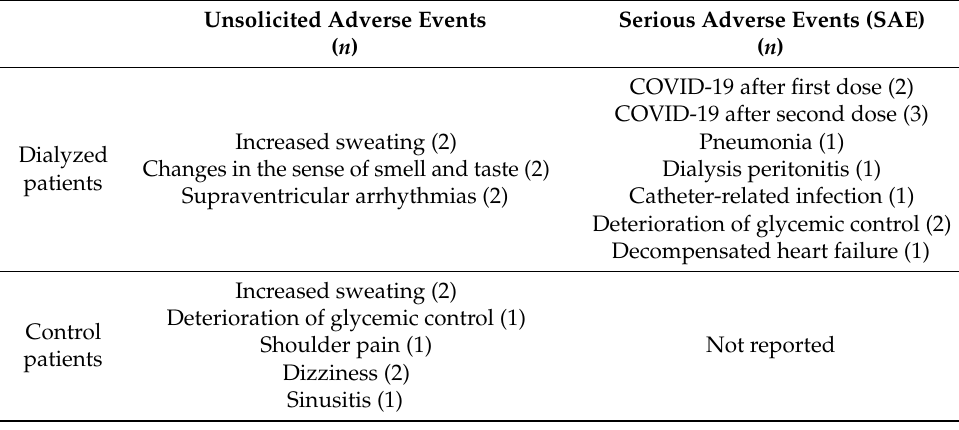
Table 3. Unsolicited adverse events and serious adverse events.